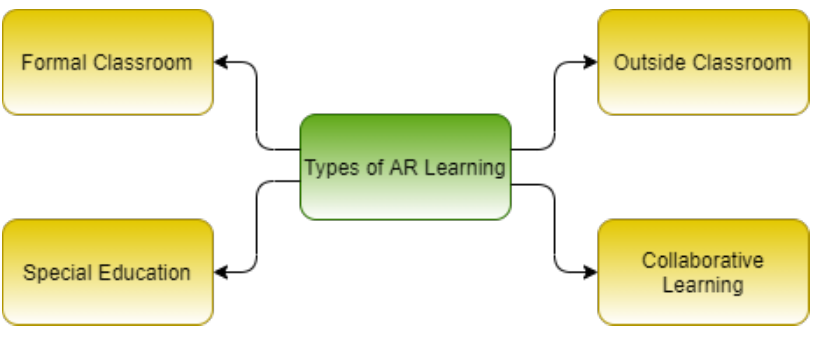
Figure 2. Types of AR learning included in this